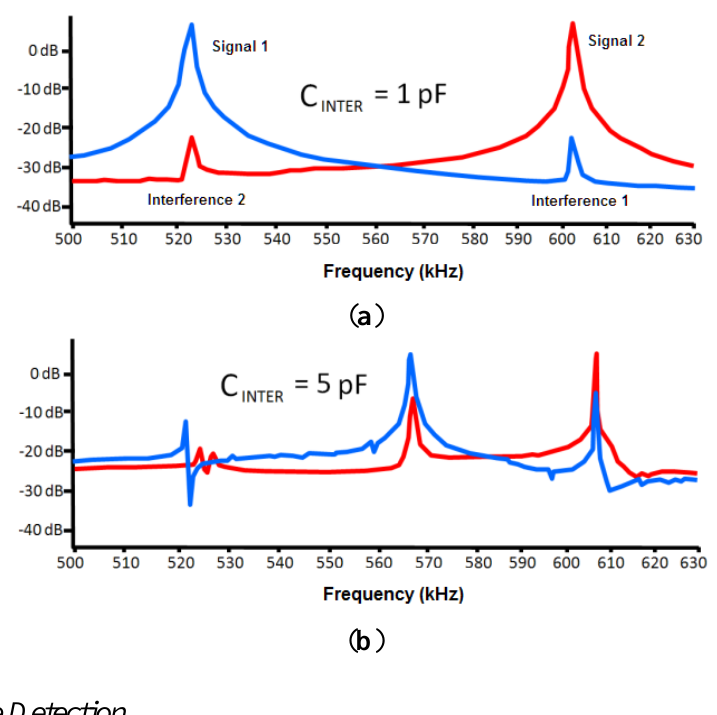
Figure 6. Simulation of the frequency signals for two sensor devices in two cases of